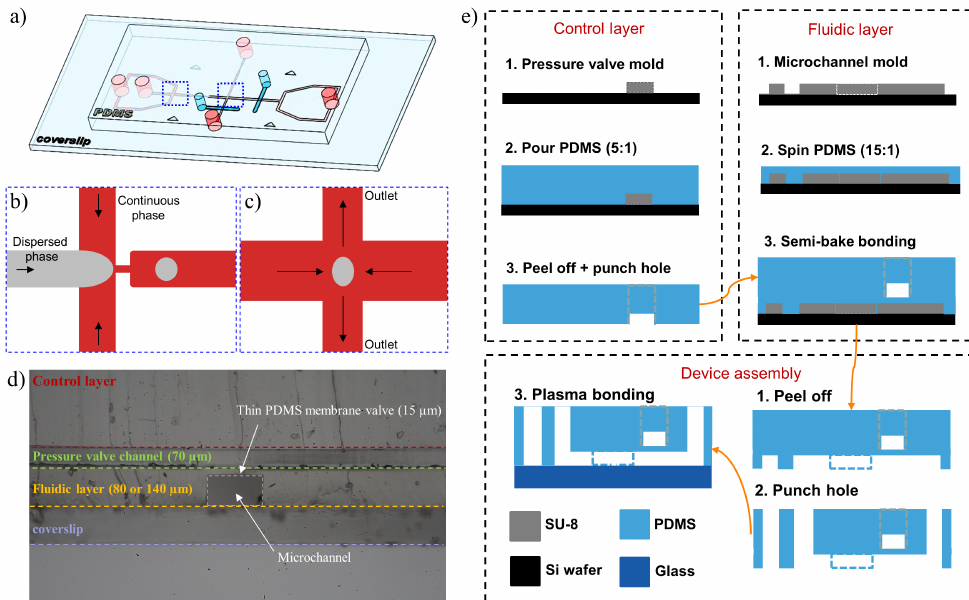
Figure 2. Microfluidic platform for droplet trapping at the cross junction: ( a ) 3D view of the microflu- idic device, showing the slide glass, double-layered PDMS microchannels with the fluidic layer (in red) and the control layer (in cyan), ( b ) droplet generation at the flow-focusing region, ( c ) droplet trapping and stretching under extensional flow, ( d ) cross-section of the double-layered PDMS device and ( e ) step-by-step procedure of fabricating the double-layered PDMS device, highlighting features in a cross-section